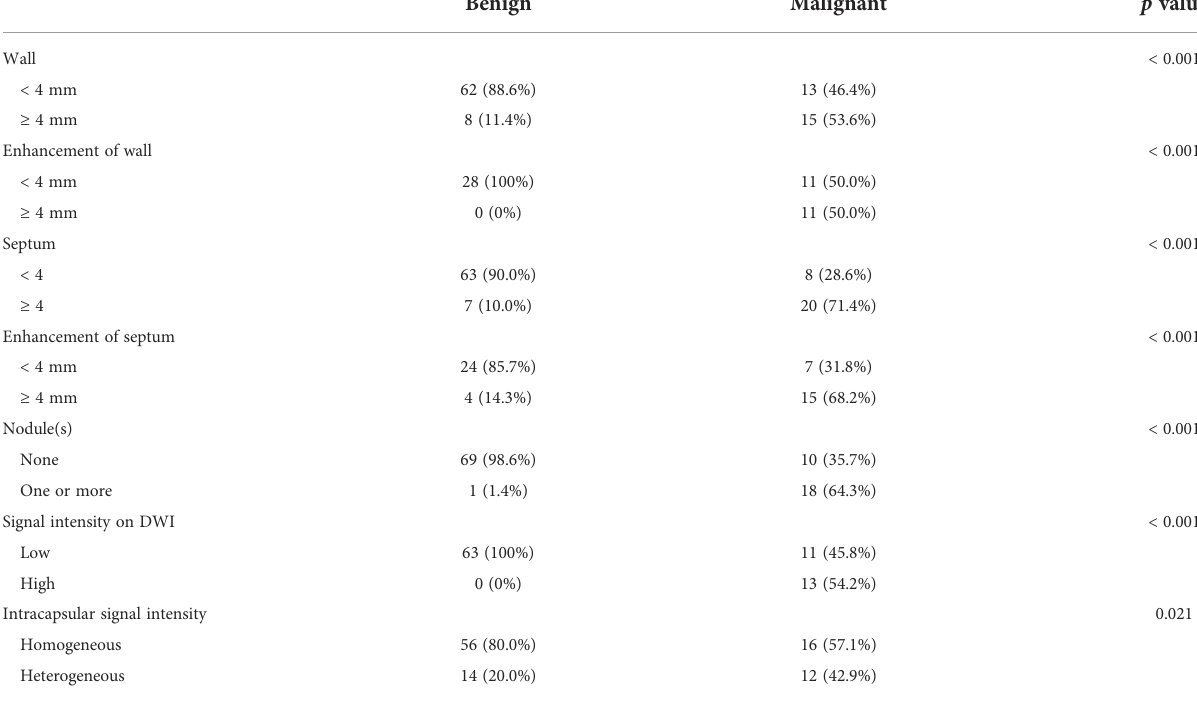
TABLE 3 Characteristics of lesions on MRI including DWI images between benign and malignant cystic renal masses.